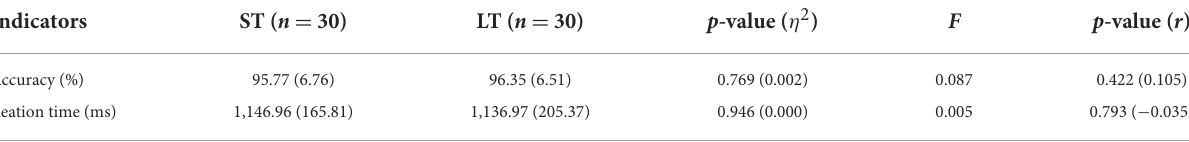
TABLE 2 The accuracy and reaction time of the Go Trials in each